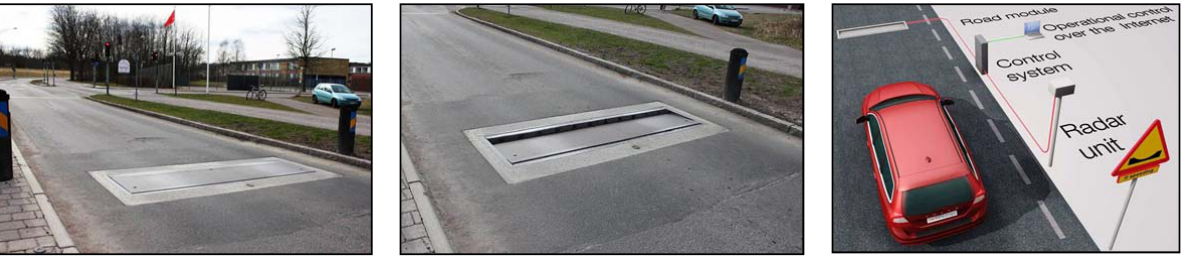
Figure 14. Actibump artificial